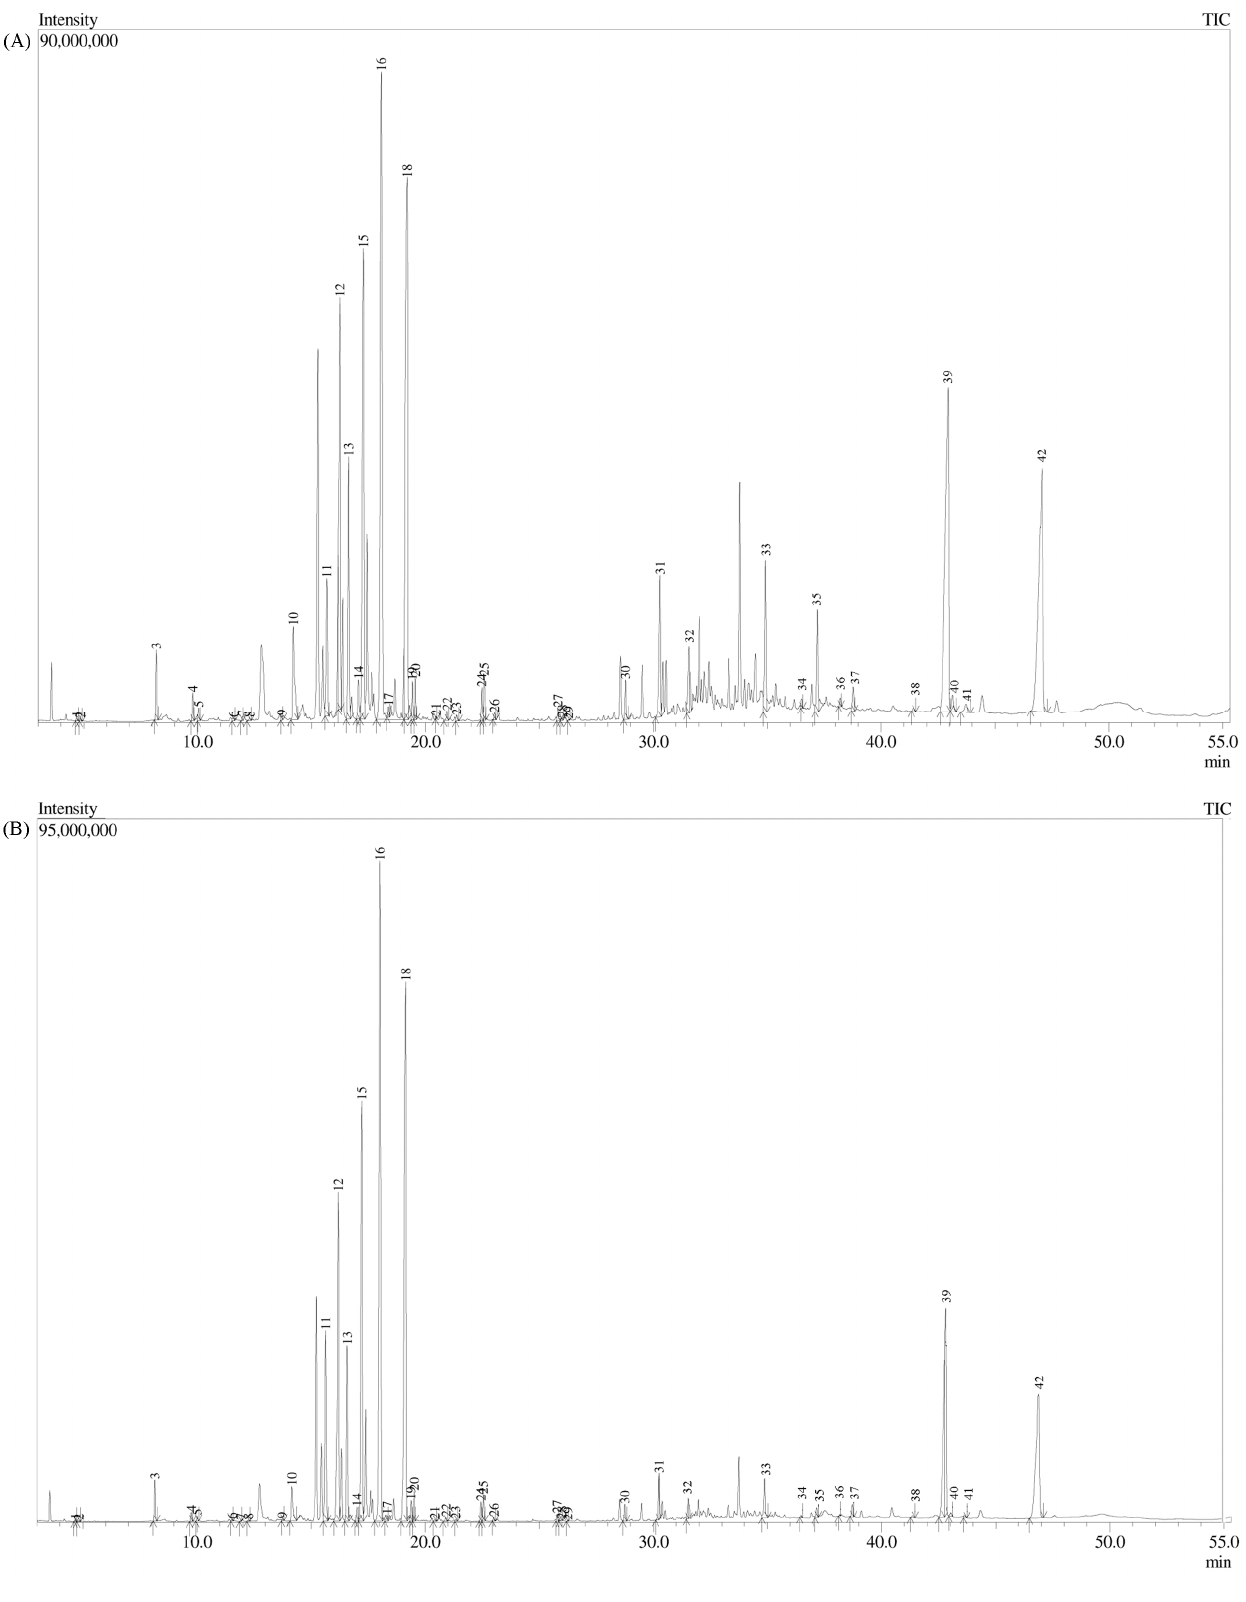
Figure 1. GC-MS chromatogram of ( A ) methanol extract from cv. Lastovka and ( B ) methanol extract from cv. Oblica extract after derivatization with trimethylsilyl (TMS). Peak assignment is given in